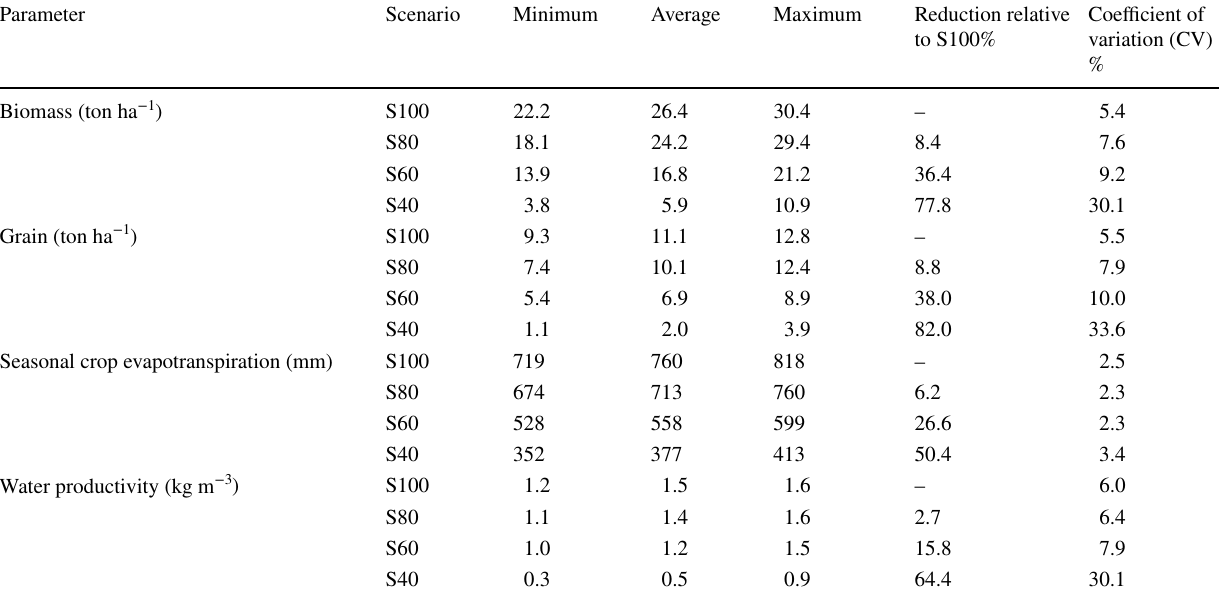
Table 2 Statistical summary of the studied parameters in the spatial analysis for the study area Parameter